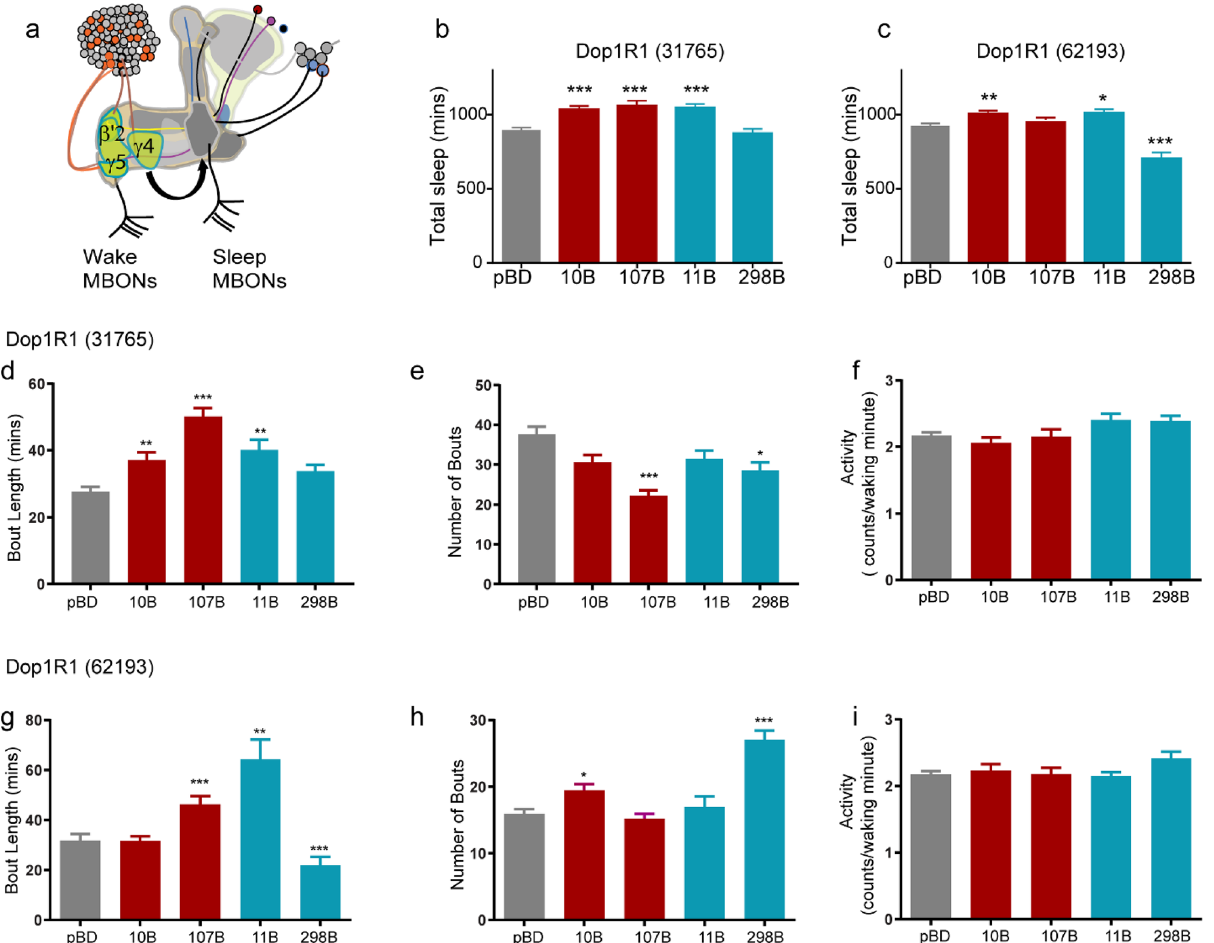
Figure 6. Knockdown of DopR1 in MB-KCs and MBONs of the sleep-regulating γ5 and β ′ 2 compartment increased sleep. ( a ) Schematic of MB wake-promoting γ5, γ4 and β ′ 2 compartments that represents the interactions between KCs, MBONs and PAM-DANs. ( b , c ) Total Sleep during a 24-h period in flies expressing UAS-DopR1 RNAi (31765 and 62193) in MB-KCs (MB010B, MB107B: red), MBONs (MB011B, MB 298B: blue) and enhancerless/empty split-GAL4 pBD (control: grey). ( d , e ) Average bout length and number of bouts in flies expressing UAS-DopR1 RNAi (31765) in MB-KCs (MB010B, MB107B: red), MBONs (MB011B, MB298B: blue) and enhancerless/empty split-GAL4 pBD (control: grey). ( f ) Activity or average beam crossings/waking minute indicative of locomotor activity of flies expressing UAS-DopR1 (31765). ( g , h ) Average bout length and number of bouts in flies expressing UAS-DopR1 RNAi (62193) in MB-KCs (MB010B, MB107B: red), MBONs (MB011B, MB298B: blue) and enhancerless/empty split-GAL4 pBD (control: grey). ( i ) Activity or average beam crossings/ waking minute indicative of locomotor activity of flies expressing UAS-DopR1 RNAi (62193). For each of the experimental groups tested we had 37–48 flies which represented 2 independent experimental trials, sample included 31765/pBD (48), 31765/MB010B (40), 31765/MB107B (38), 31765/MB011B (38), 31765/MB298B (37), 62193/pBD (47), 62193/MB010B (39), 62193/MB107B (44), 62193/MB011B (43), and 62193/MB298B (47). Data represents mean and SEM, * indicates p < 0.05, ** indicates p < 0.001 and *** indicates p < 0.0001. Statistical analysis was one-way ANOVA and Dunnett’s paired comparison with control for ( b , c , f , i ) and Kruskal–Wallis non-parametric one-way ANOVA and Dunn’s post-hoc correction for ( d , e , g , h